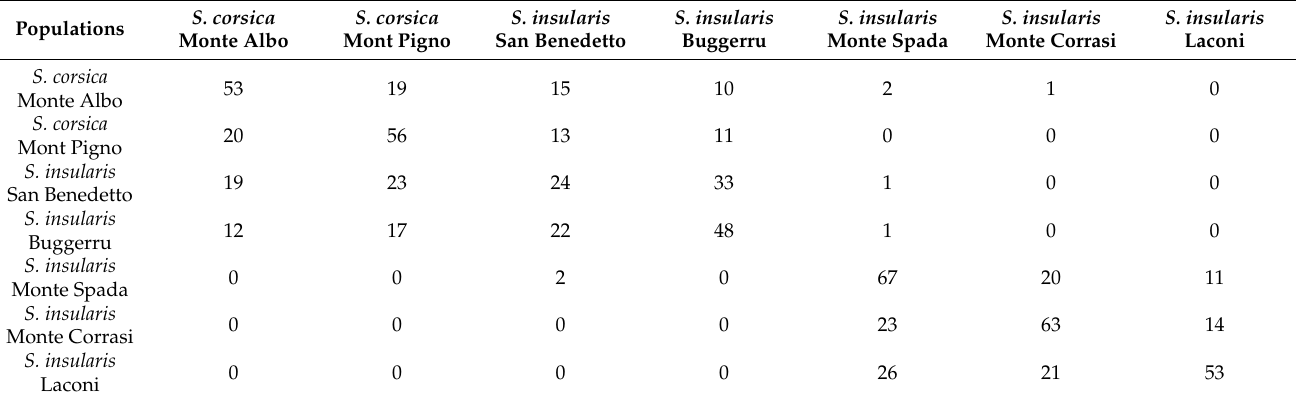
Table 7. Cypsela morpho-colorimetric analysis of all the studied Santolina populations. Confusion matrix of the LDA analysis applied comparing each population of S. corsica and S. insularis .